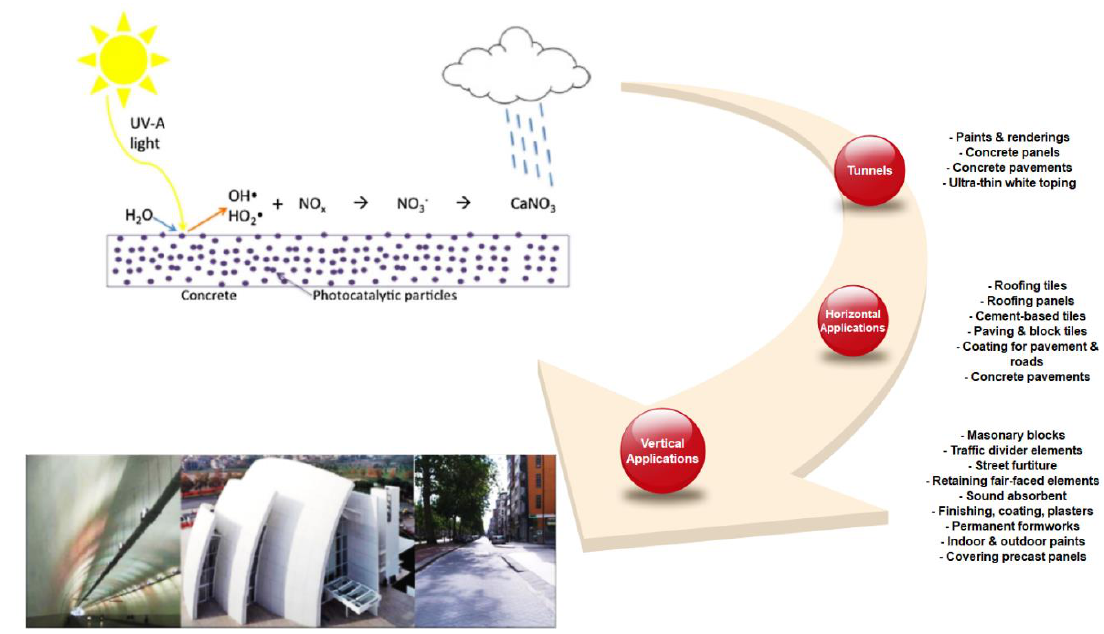
Figure 6. Possible applications of photocatalysis cement-based materials as reported in the literature (schematic of the photocatalytic concrete from [6]). From left to right: painting of Umberto tunnel in Rome, Dives in Misericordia church in Rome [41], and pavement blocks on Leien of Antwerp in Belgium [18].